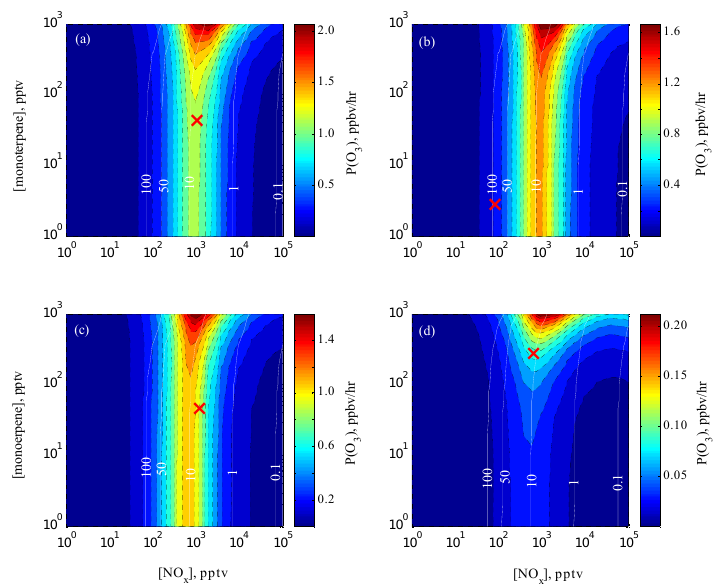
Fig. 13. Calculated dependence of P (O 3 ) upon monoterpenes concentrations and NO x concentrations. Other conditions including j (O 1 D) are constrained to those observed at: (a) 08:40JST of 18 September, (b) 13:10JST of 21 September, (c) 13:00JST of 20 September and (d) 06:40JST of 21 September. The contour plots of Φ are shown by whiter lines. Red crosses denote the observed concentrations of monoterpenes and NO x at the selected time.